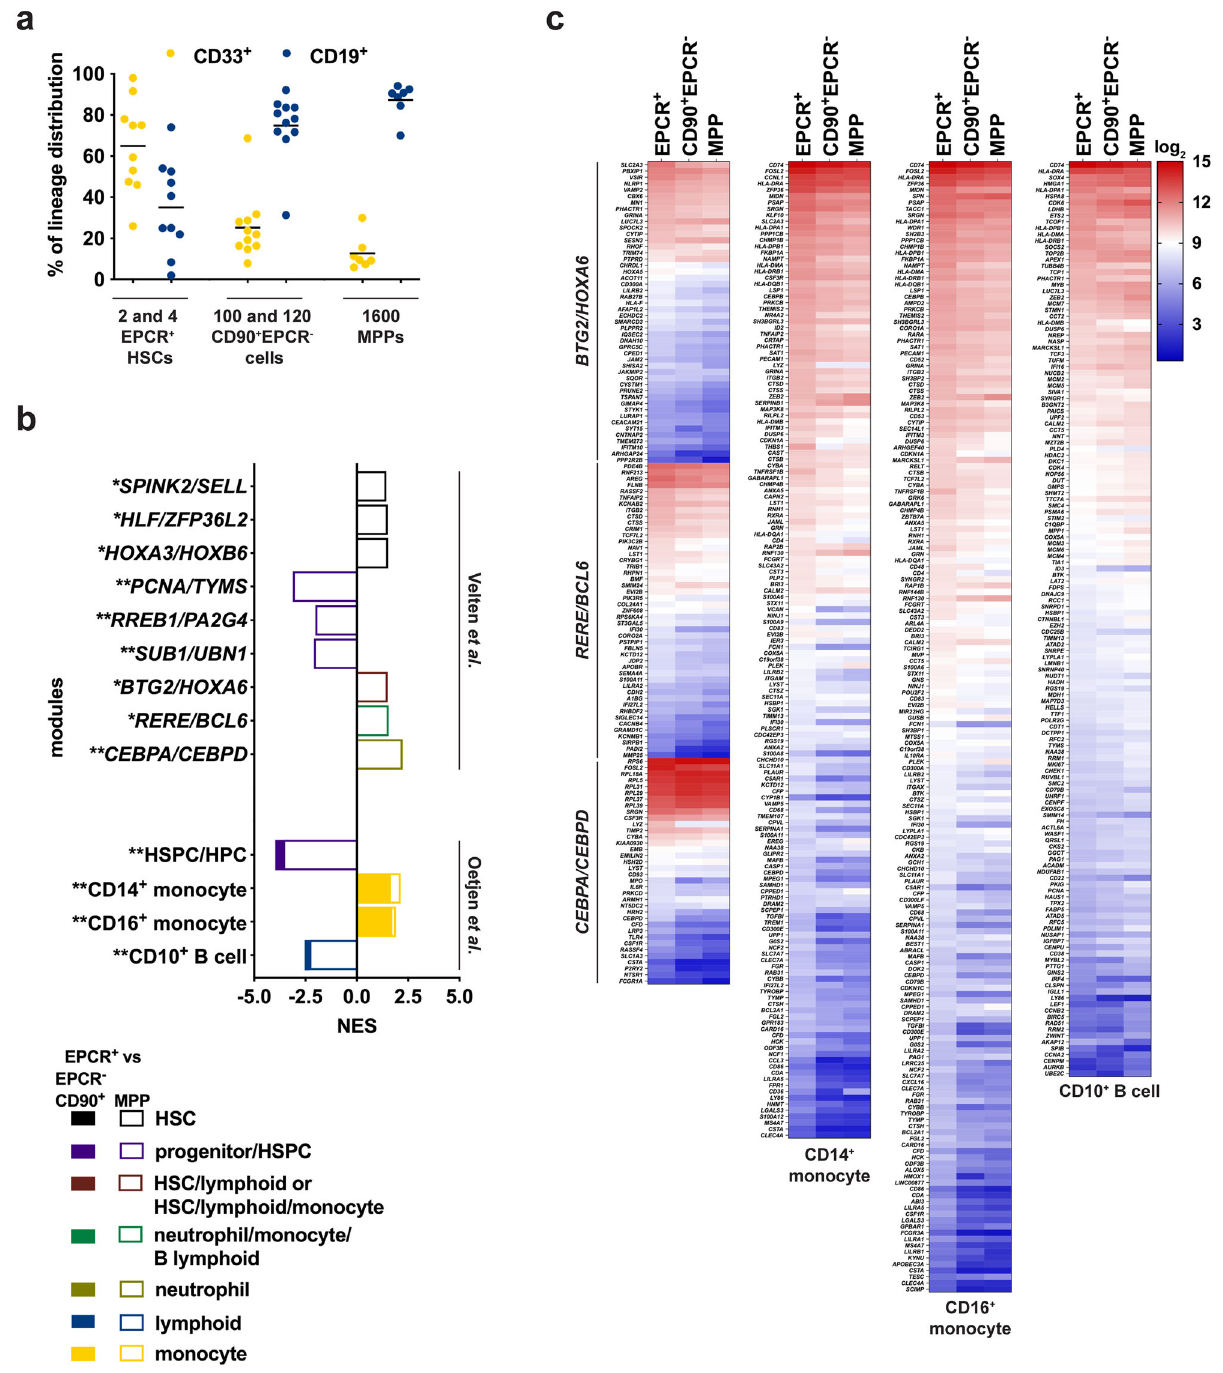
Fig. 6 Unique transcriptomic priming supports a in vivo balanced multilineage output of EPCR + HSCs. a In vivo human myeloid (CD33 + ) vs B lymphoid (CD19 + ) differentiation outputs of EPCR + , CD90 + EPCR - and MPP cells in 1 ry NSG mice at 12 wks post transplanted with the indicated cell doses ( n = 7 – 11 mice); mean lines are shown. b Denoted lineage-priming gene modules 8,9 enriched in EPCR + HSCs, CD90 + EPCR − progenitors, and MPPs; NES, normalized enrichment scores enriched (FDR p -value *<0.1 and **< 0.05 by pre-ranked Gene Set Enrichment Analysis, GSEA; p -values were adjusted using Benjamini – Hochberg method) are shown. c Heatmap of DE genes (padj <0.05 and with cut-off of log 2 FC ± 0.4, see Supplementary Data 4) between EPCR + vs EPCR - CD90 + vs MPP found in the enriched lineage-priming gene modules shown in ( b ). The scale represents log 2 of normalized transcript expression values. Source data are provided as a Source Data fi (Fig. 7g and Supplementary Fig. 6b). To date, these fi ndings strongly suggest that EPCR + cells represent a human HSC population that is inherently harbouring a high multipotential ability and homogenous transcriptomic pro fi le.